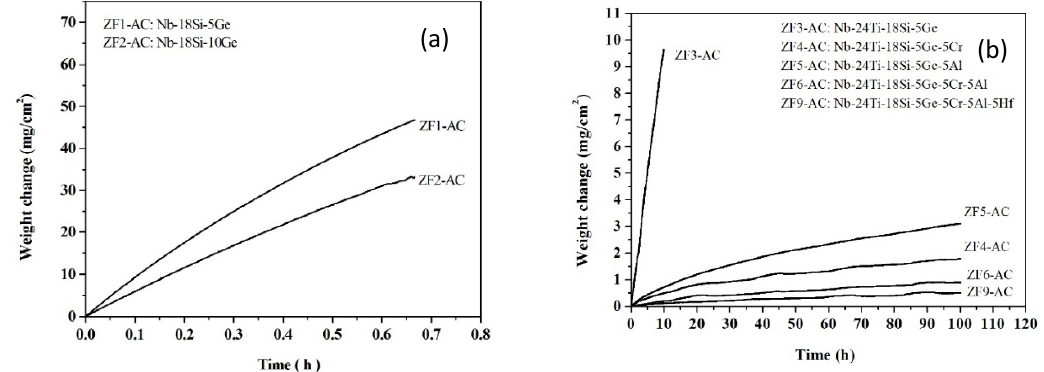
Figure 1. TG curves at 800 °C of the alloys ( a ) ZF1 and ZF2 (effect of Ge addition), ( b ) ZF3 (effect of synergy of Ti and Ge), ZF4 (effect of synergy of Ti, Cr, and Ge), ZF5 (effect of synergy of Ti, Al, and Ge), ZF6 (effect of synergy of Ti, Cr, Al, and Ge), and ZF9 (effect of synergy of Ti, Cr, Al, Ge, and Hf). Notice the different axes used in ( a ) and ( b ).